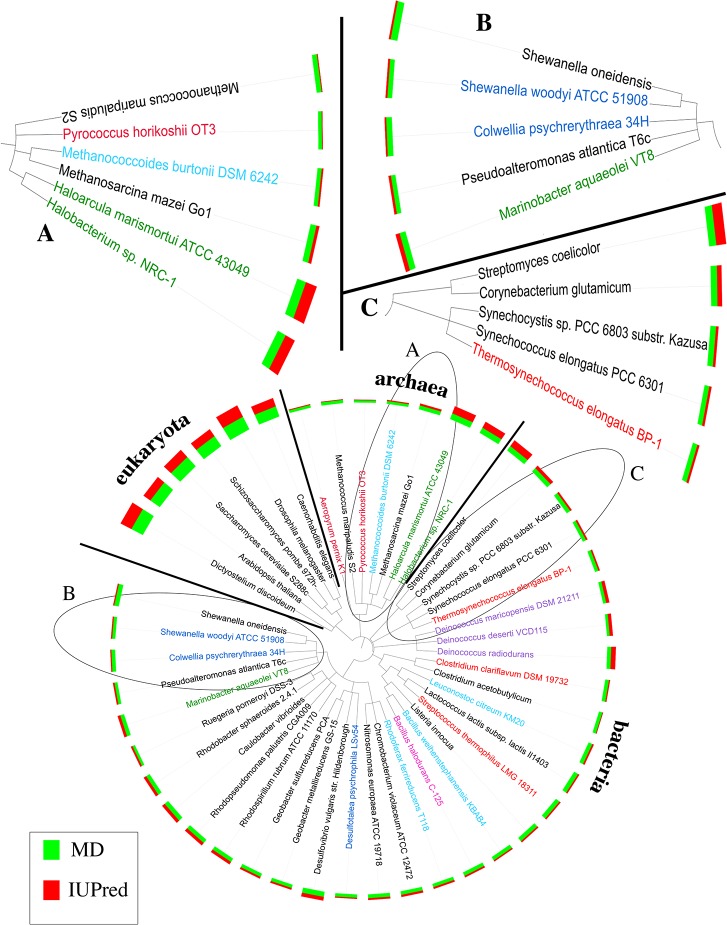
Protein disorder content differs for habitat, not for phyla.We represent the protein disorder content for the organisms in similar habitats (left panel) and those in the same phyla (right panel). The y-axes give the percentage of proteins with at least one region of ≥30 consecutive residues predicted as disordered by MD (A), NORSnet (B) and IUPred (C). The x-axis on the left side marks the different environmental groups (S2 Table); on the right side marks the studied phylogenetic groups (S14 Table). The groups which are significant for a paired Wilcoxon Test are marked with * (P<0.05) or ** (P<0.005).